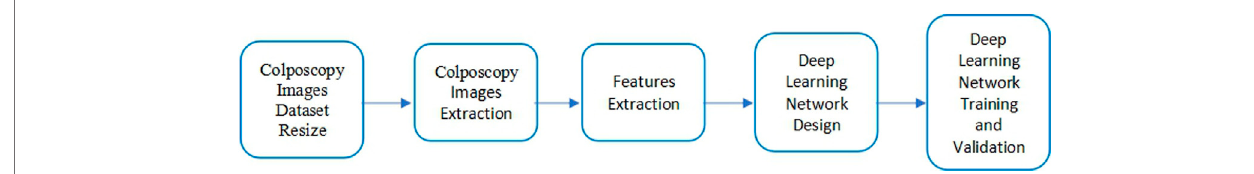
FIGURE 1 | Work fl ow diagram of the deep learning classi fi cation model.